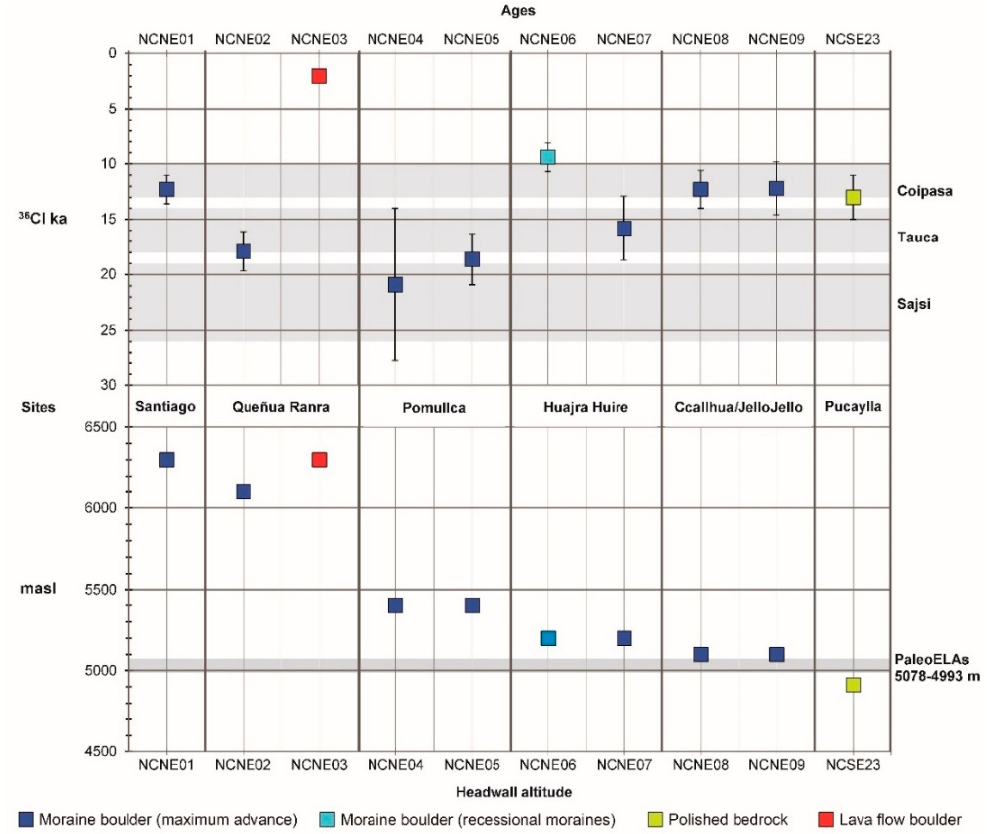
Figure 10. Differences in altitude between the sampled surfaces and the flow sources (glaciers or lava).